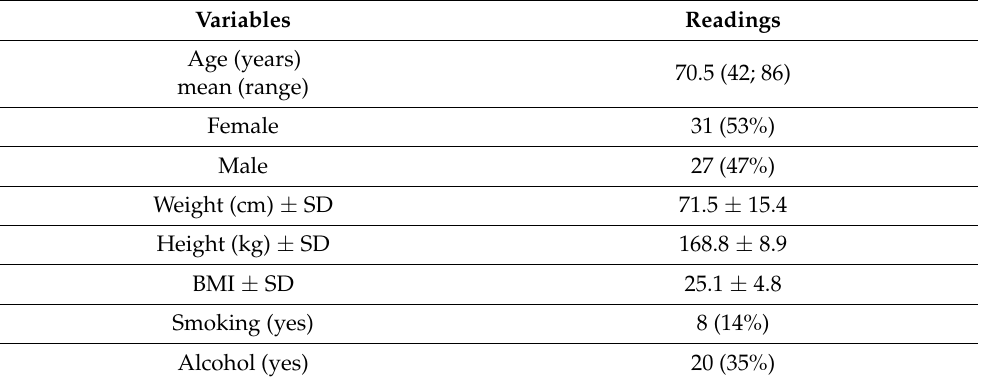
Table 1. Basic characteristics of the study population ( n =